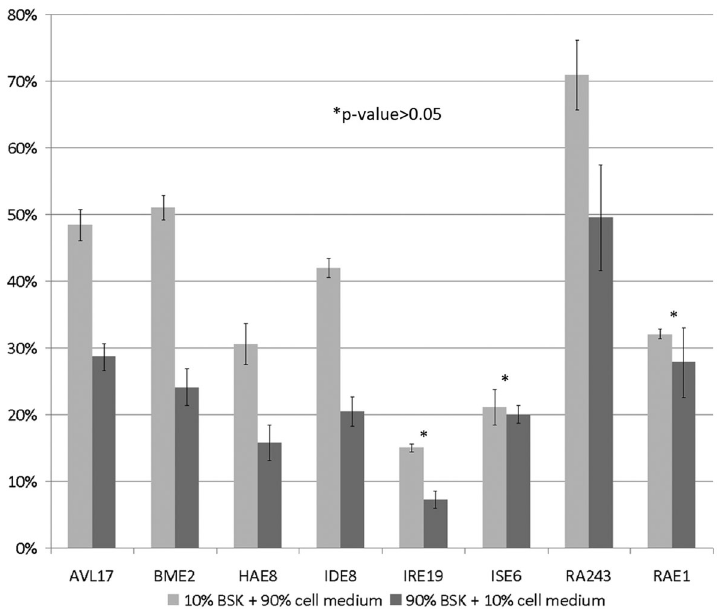
Figure 1. Flow cytometry overlays showing the association between Borrelia burgdorferi stained with PKH67 and the tick cell lines AVL/CTVM17, BME/CTVM2, HAE/CTVM8, IDE8, IRE/CTVM19, ISE6, RA243 and RAE/CTVM1 in medium containing 10% BSK-H + 90% tick cell medium. Red lines represent the cultures inoculated with B. burgdorferi ; black lines represent the uninfected cell controls. The values inside the graphs are the mean percentage of cells with internalized spirochetes.